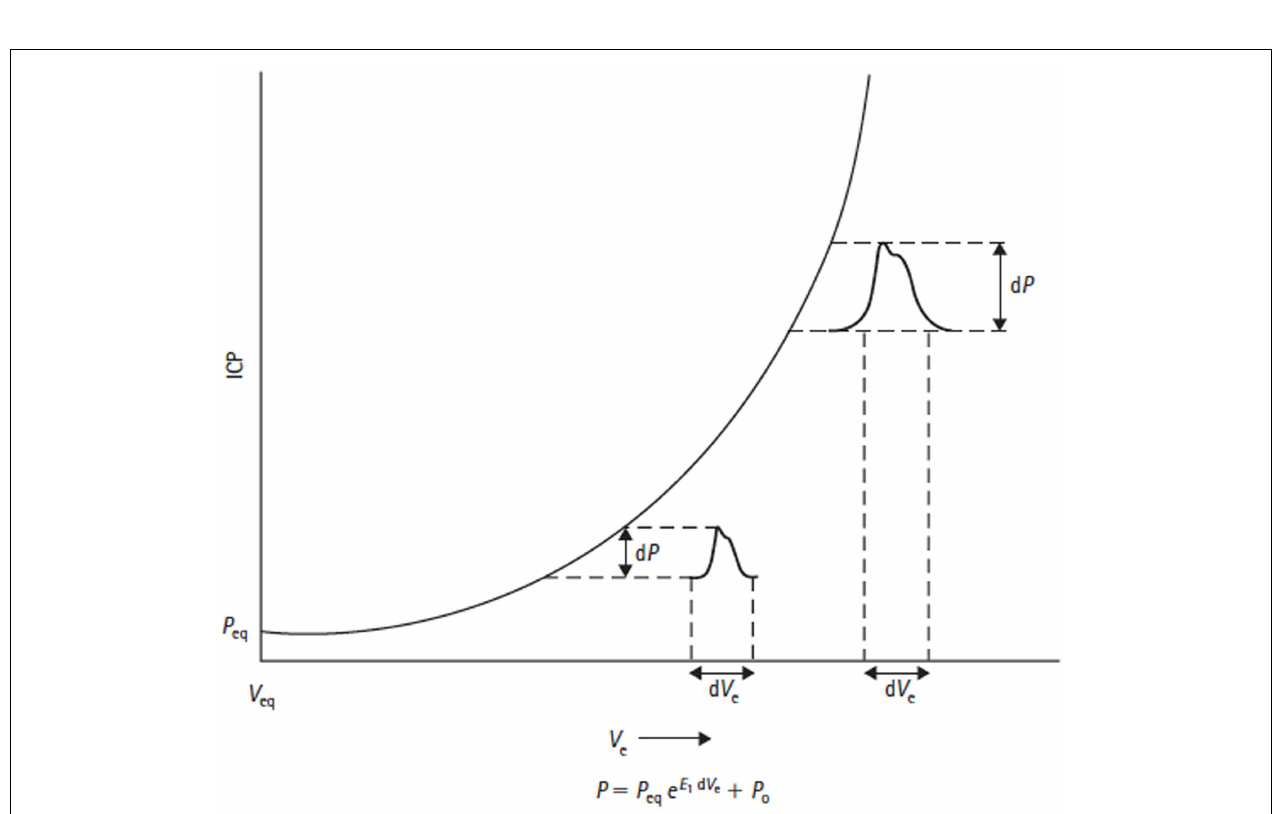
( V e ) increases.This is due to the exponential nature of the curve, which is described mathematically by the equation below the figure, where E 1 is the elastance coefficient and determines the elastance at a given pressure. P eq = intracranial equilibrium pressure, P 0 = ICP at zero